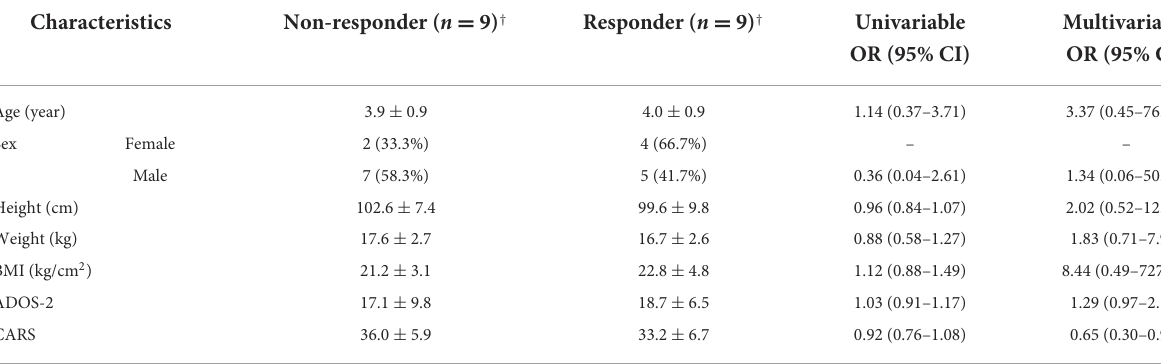
TABLE 4 Logistic regression analysis: characteristics predicting treatment